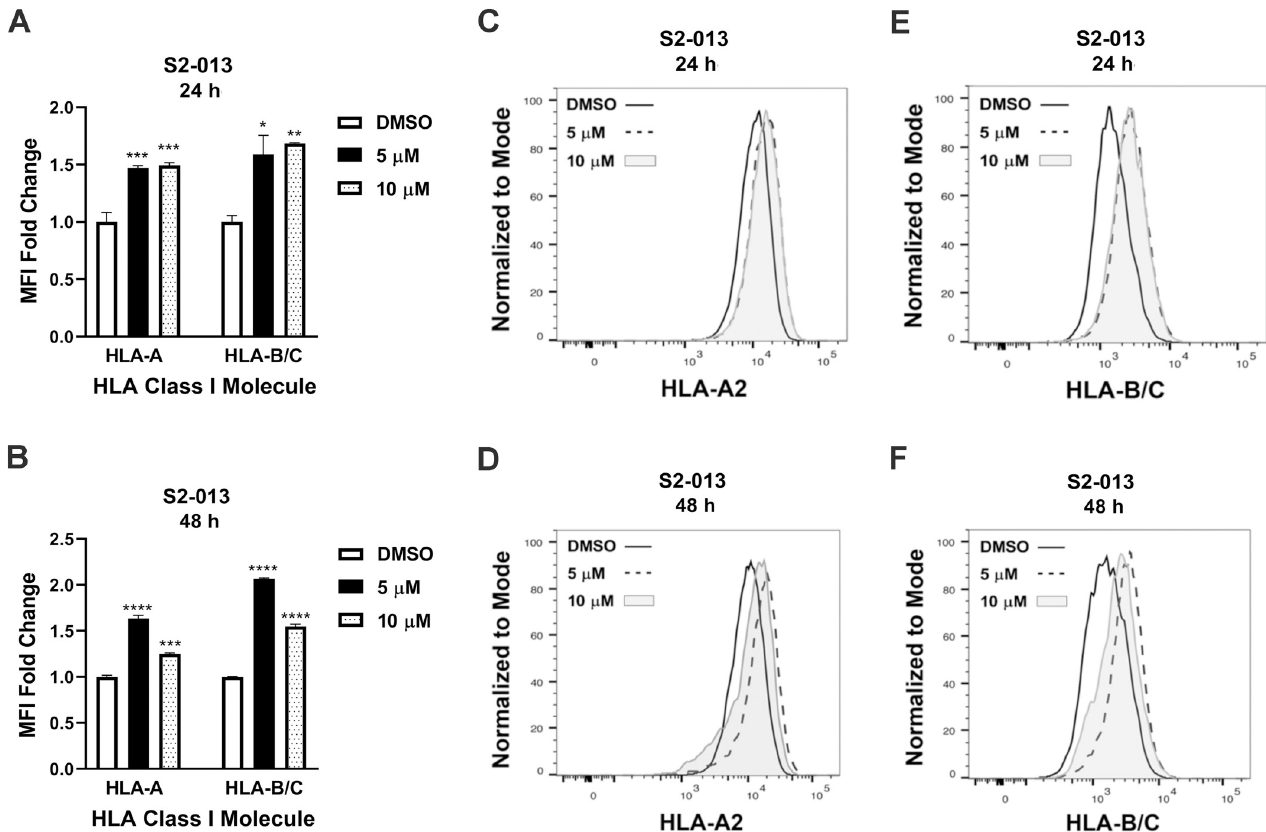
Fig 10. MHC class I expression on S2-013 pancreatic cancer cells is increased following M344 treatment. After 24- or 48-hour treatments with 0.1% DMSO (vehicle control) or with M344 at 5 or 10 μ M concentrations, cell surface expression was monitored using flow cytometry with the BB7.2 antibody for peptide- occupied HLA-A2 and the B1.23.2 antibody that detects HLA-B/C. The bar graphs depict the median fluorescence intensity (MFI) fold change relative to the 0.1% DMSO control treatment for ( A ) 24-hour M344 treatment and ( B ) 48-hour M344 treatment. Triplicate wells for each concentration and time point were analyzed. Each error bar represents the standard error of the mean. Statistical comparison of the results from the 0.1% DMSO control treatment versus treatment with each M344 concentration was performed using Ordinary One-way ANOVA with Dunnett’s Multiple Comparisons Test in GraphPad Prism Version 8.4.2. The asterisks indicate the p values: � p < 0.05, �� p < 0.01, ��� p < 0.001, ���� p < 0.0001. Representative histogram overlays are shown for S2-013 ( C ) HLA-A2 expression at 24 hours post-treatment with M344, ( D ) HLA-A2 at 48 hours post-treatment with M344, ( E ) HLA-B/C at 24 hours post-treatment with M344, and ( F ) HLA-B/C at 48 hours post-treatment with M344. In the histograms, solid lines represent 0.1% DMSO treatment, dashed lines represent 5 μ M M344 treatment, and solid gray areas represent 10 μ M M344 treatment.